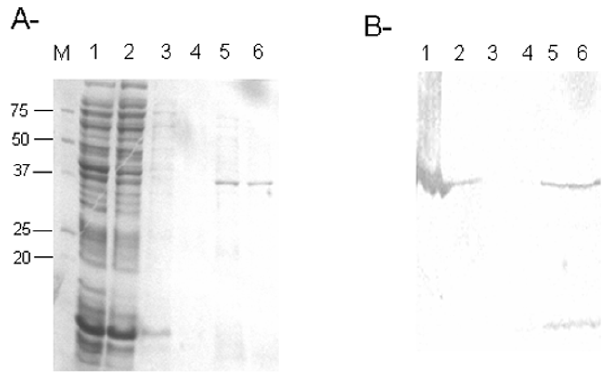
Figure 2. SDS-PAGE (A) and western blot (B) analysis of protein factions containing IntI1(his) 6 . Lane M: molecular weight markers in kDa; lane 1: soluble crude extract from E. coli DH5 a expressing IntI1(his) 6 ; lane 2: non-retained fraction; lanes 3, 4, 5 and 6: fractions obtained after elution with respectively 20, 100, 250 and 350 mM imidazole. Western blot was performed using anti-(his) 6 Ct antibodies (INVITROGEN).